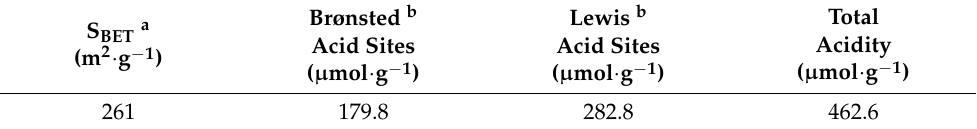
Figure 5. X-ray powder diffraction patterns of as-received natural zeolite (NZ) and acidic transformed natural zeolite (AZ) samples. Clinoptilolite (C), mordenite (M) and quartz (Q). Table 3. Textural and acidic content of acidic transformed natural zeolite.